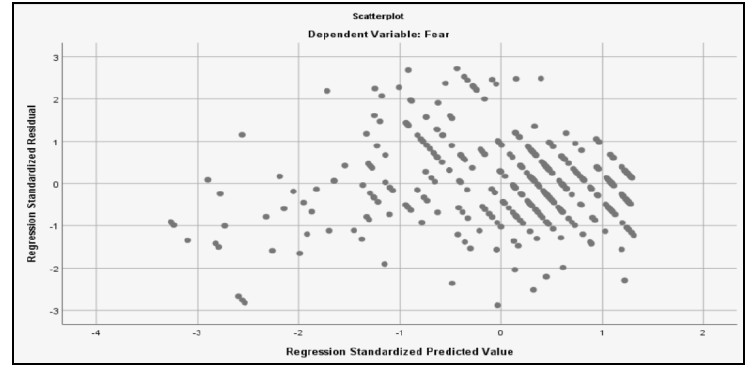
Figure 3: Heteroscedasticity